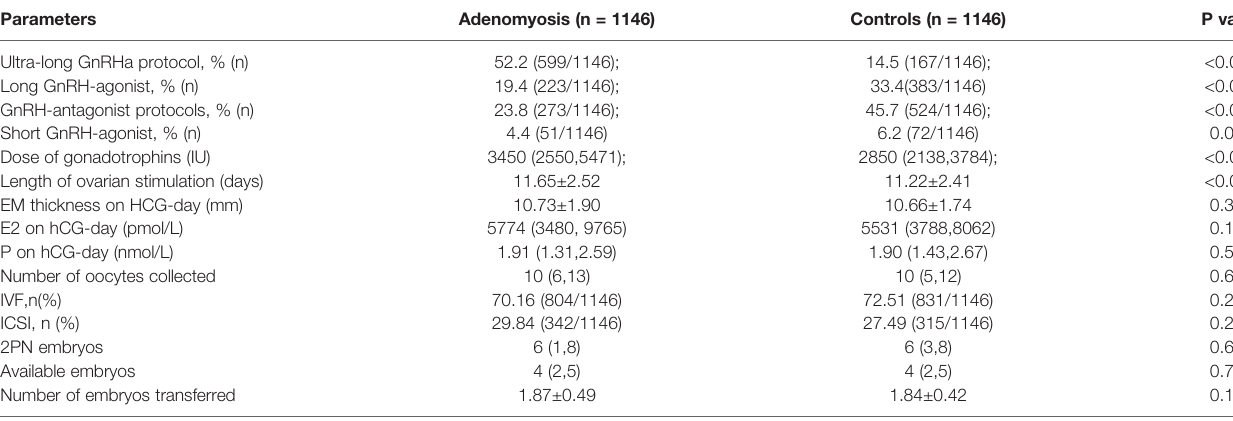
TABLE 2 | Characteristics of IVF-ICSI stimulation cycles.